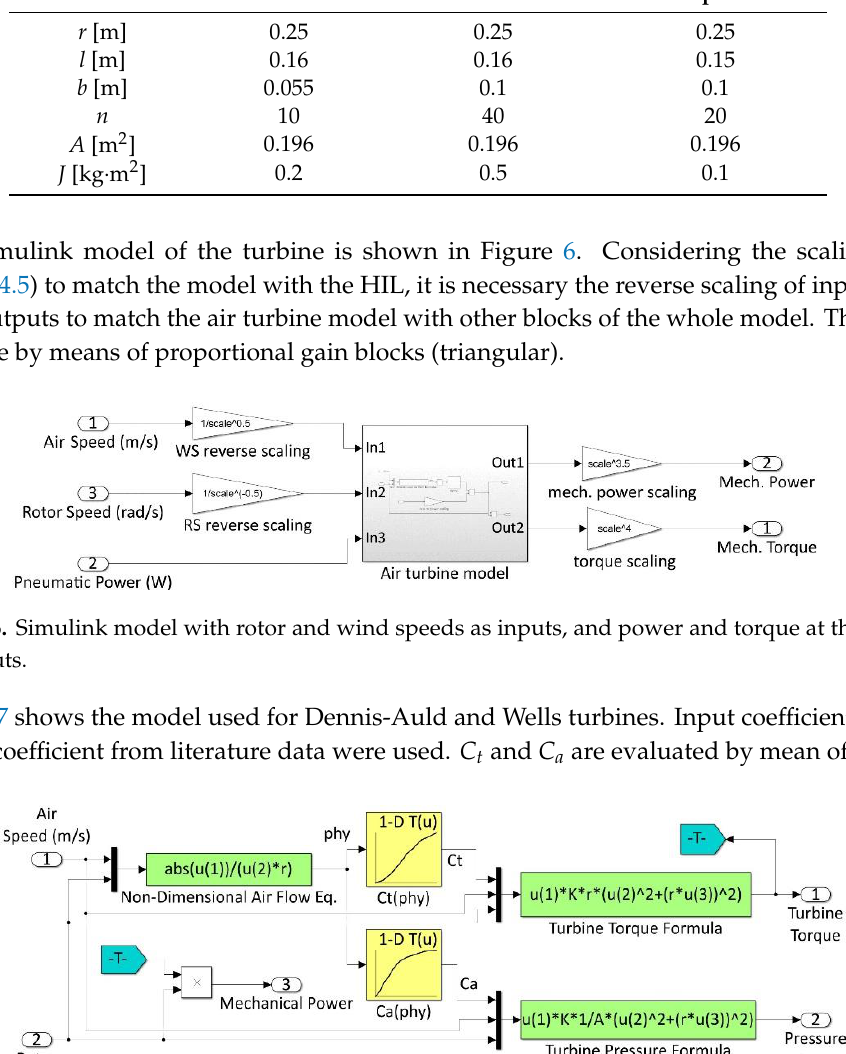
Figure 8. Simulink model of air turbine using efficiency vs. flow coefficient characteristic. 4.3. Drive Train Modeling The following well-known equation of rotating mechanical systems considering the viscous friction can be used to model the generator: 𝑇 𝑚 − 𝑇 𝑒 = 𝐽 ∙ 𝑑𝜔 𝑟 𝑑𝑡 + 𝑇 𝑓𝑟𝑖𝑐𝑡𝑖𝑜𝑛 = 𝐽 ∙ 𝑑𝜔 𝑟 𝑑𝑡 + 𝐾 𝑓 𝜔 𝑟